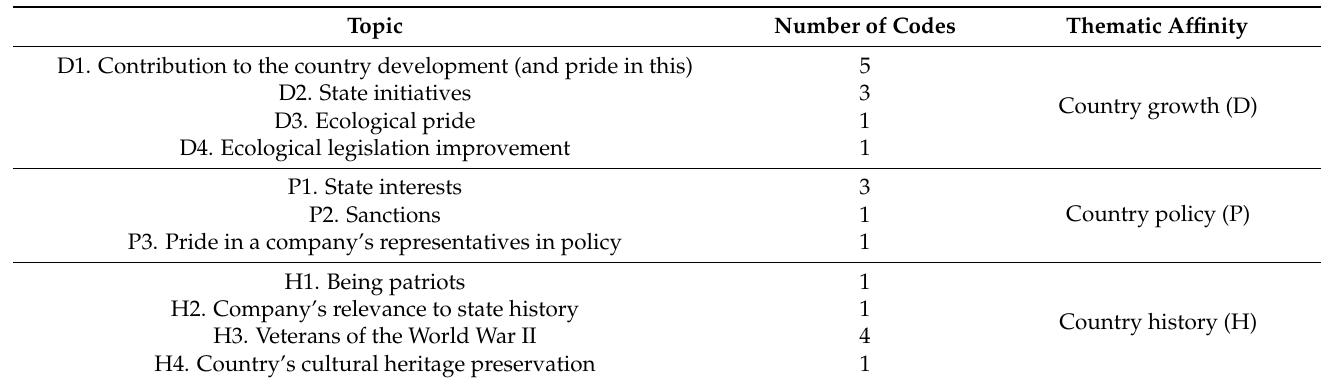
Table 3. Topics of patriotism-related notions in the analyzed codes of